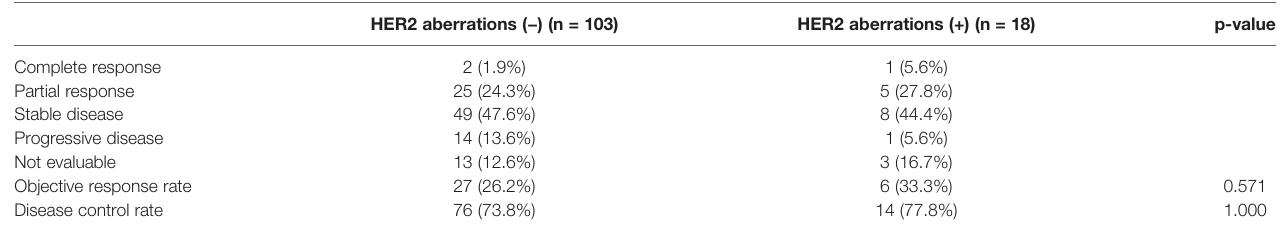
TABLE 2 | Objective response rate to chemotherapy.